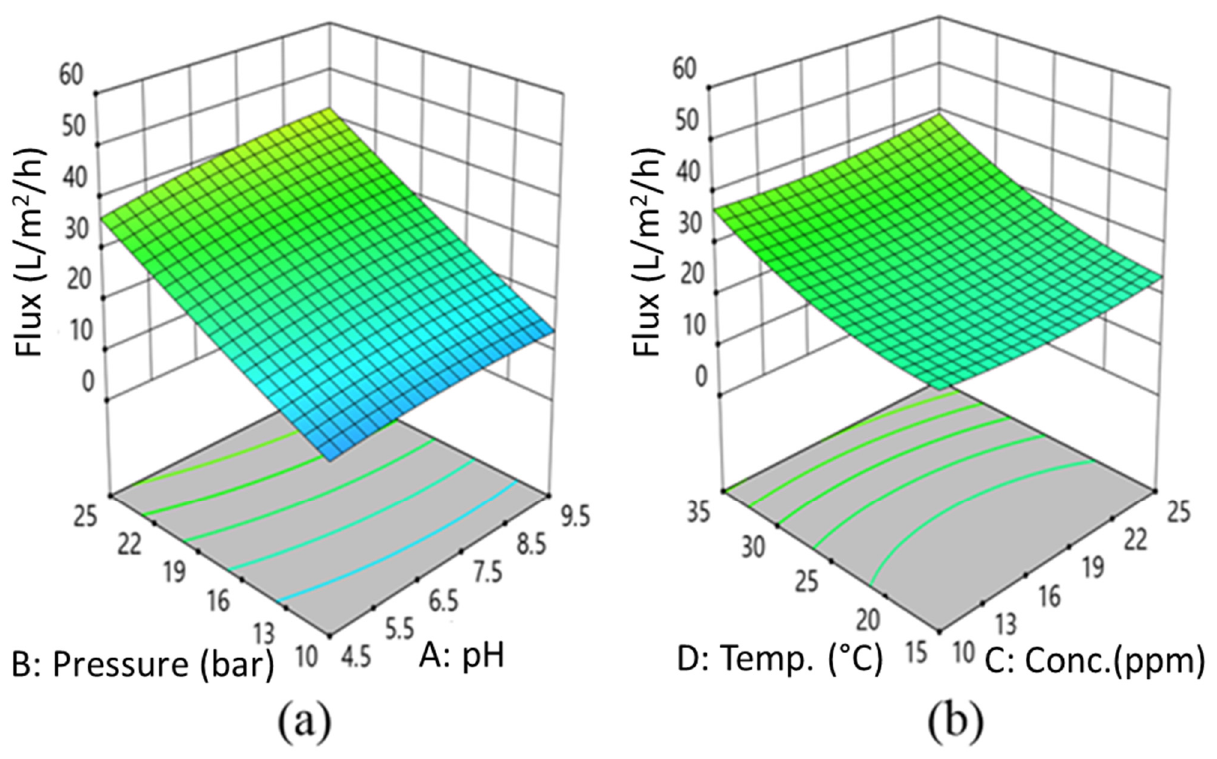
Figure 2. RSM plot for permeate flux. ( a ) Effect of pressure and pH. ( b ) Effect of temperature and concentration. Table 3. Comparison of rejection efficiency of metals ions by NF membrane between this and other studies in the